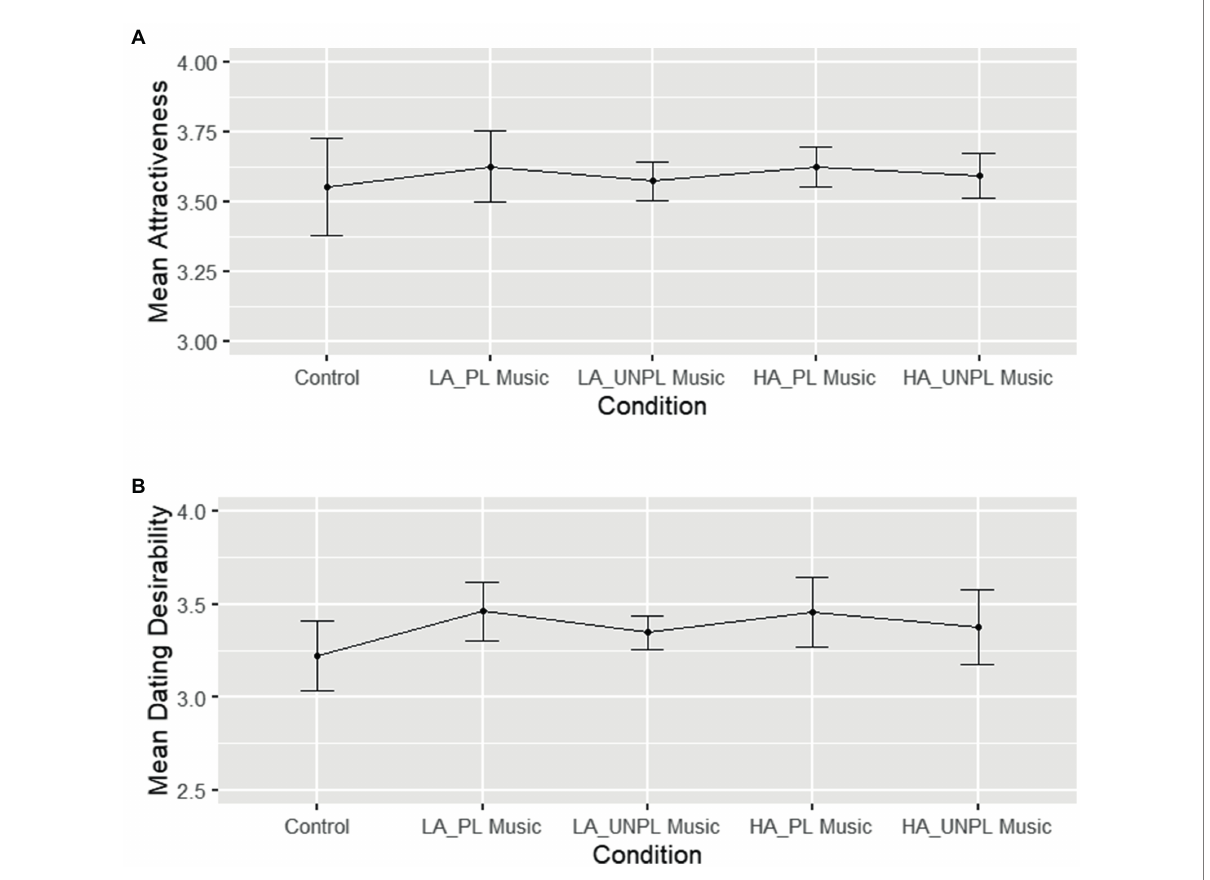
FIGURE 2 Males’ average facial attractiveness and dating desirability ratings of females given for each experimental condition. (A) Average facial attractiveness ratings. (B) Average dating desirability ratings. Error bars represent correlation- and difference-adjusted 95% confidence intervals. LA, low-arousing; HA, high-arousing; PL, pleasant; UNPL, unpleasant. Scales range from 1 to 7, with one indicating very low attractiveness/dating